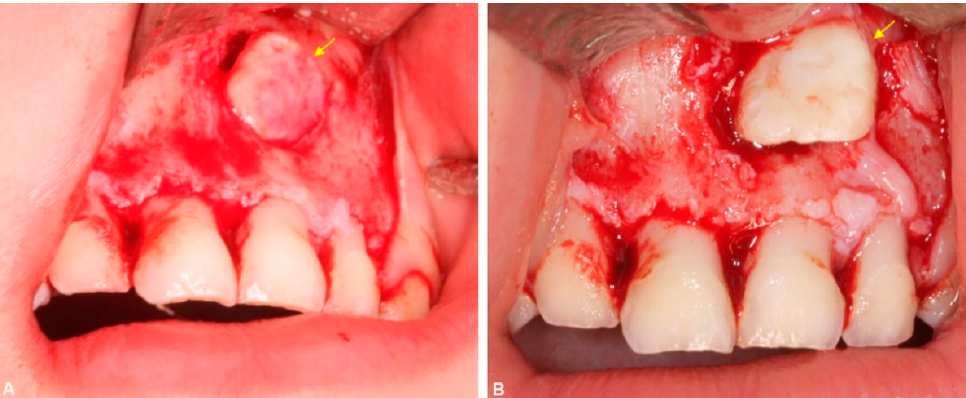
Figure 3. ( A ) Photo of the exposed tooth after overlying bone removal; ( B ) Photo of the reposi- tioned tooth, arrow: developing central incisor.